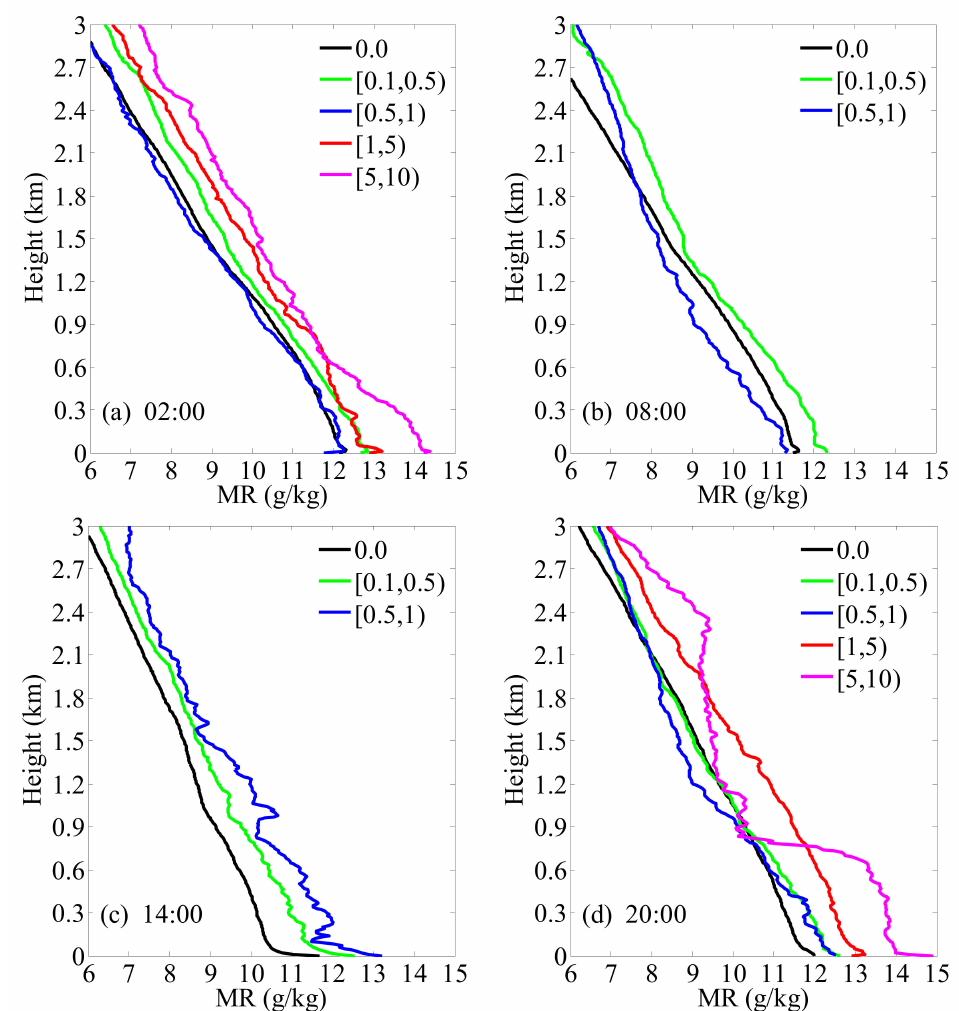
Figure 5. Atmospheric specific humidity profiles in different precipitation grades at launch times in Jiulong during 2013–2020. ( a ) 02 LST, ( b ) 08 LST, ( c ) 14 LST and ( d ) 20